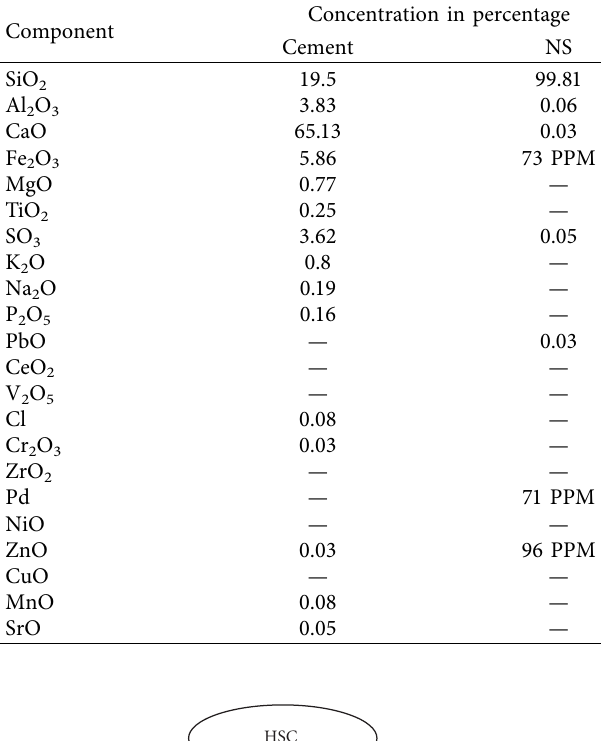
Table 2: Chemical components in cement and nanosilica.